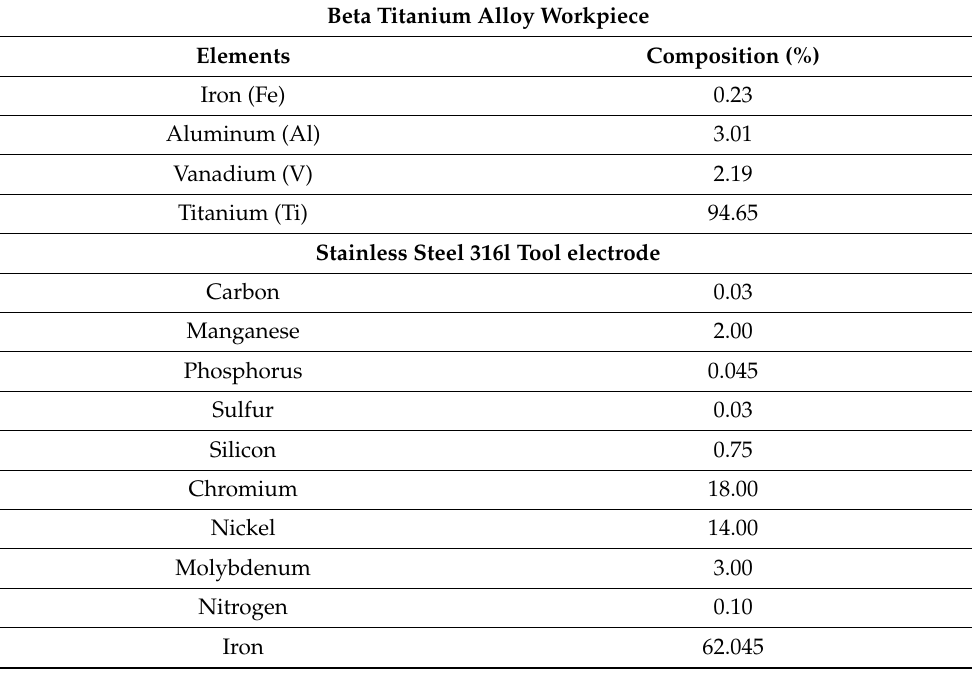
Table 1. Chemical Composition of workpiece and tool electrode.